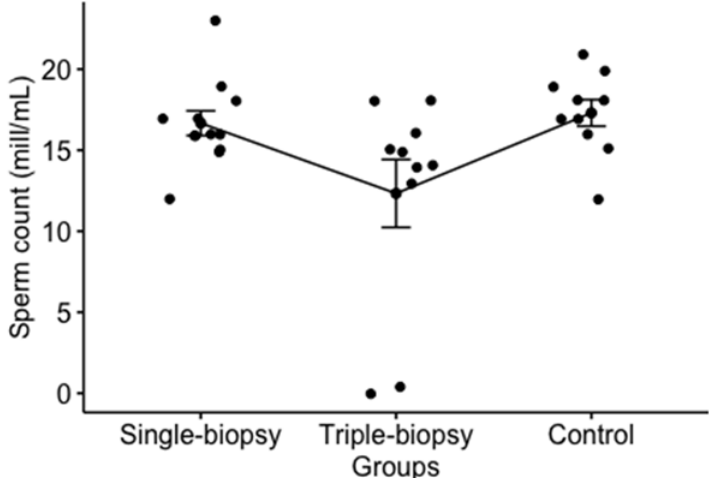
Figure 4. Difference in left testicular volume between the experimental groups (Kruskal-Wallis test; p < 0.001).